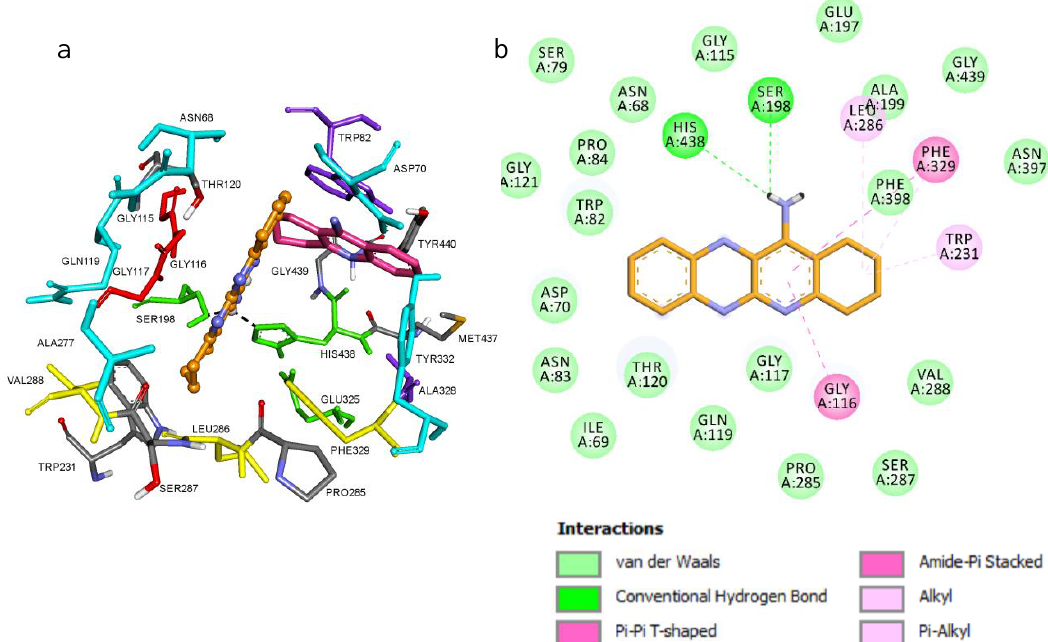
Figure 4. ( a ) Molecular docking model for compound QT78 and tacrine within the hBuChE binding-site. Compound QT78 is colored orange, and tacrine, in cherry. Different subsites of the active site were colored: catalytic anionic site (CAS) in green, oxyanion hole (OH) in red, choline binding site in violet (CBS), acyl binding pocket (ABP) in yellow, and peripheral anionic site (PAS) in blue. Hydrogen bonding interactions are shown in dashed black lines. ( b ) Two-dimensional interaction map of compound QT78 , which is bound to the active site of hBuChE.